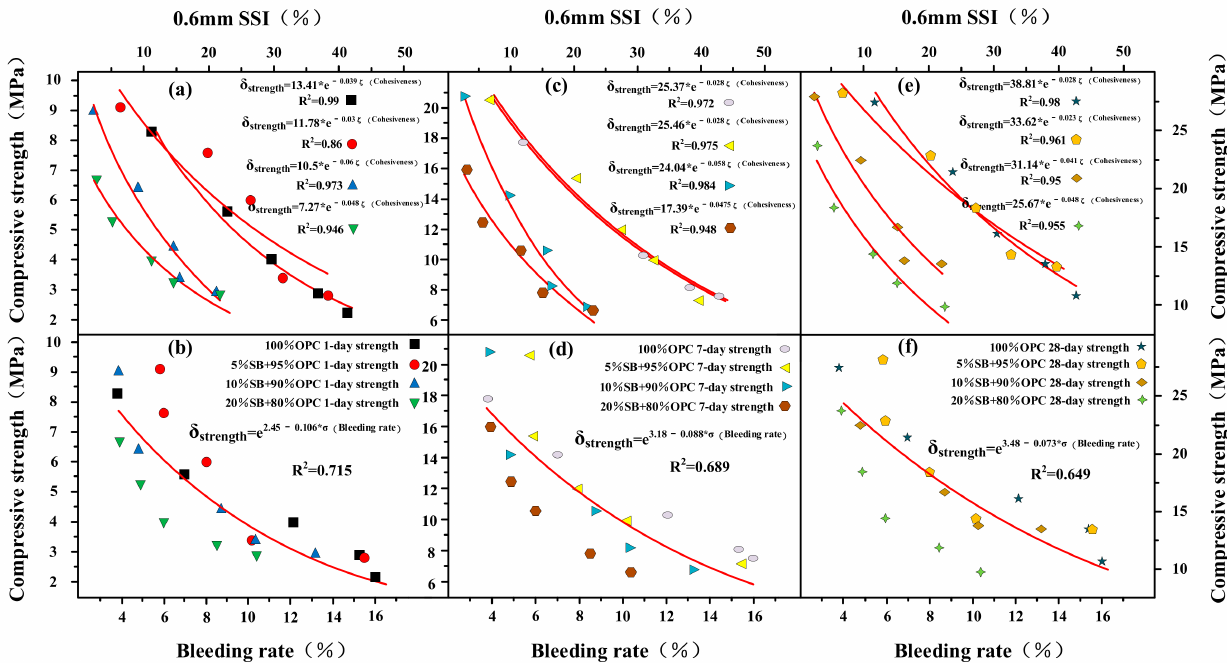
Figure 16. Bleeding rate and cohesiveness versus 1 day ( a , b ), 7 days ( c , d ), and 28 days ( e , f ) of compressive strength.